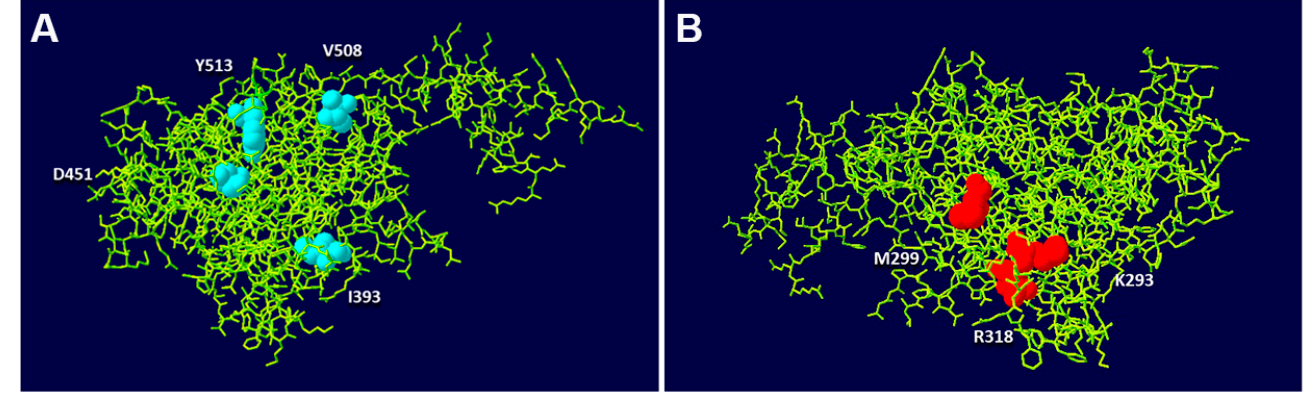
Figure 6. Residues affected by missense mutation spatially segregate according to biochemical impairment and phenotype severity. Residues affected by mutations from group 2 ( A ) and some of those in group 1 ( B ) (see text for details), were mapped on the 3D structure of the phosphatase domain of OCRL1 (PDB file 4CMN). Panels A and B correspond to two views of the OCRL1 phosphatase domain crystal structure after a rotation of ≈ 180 degrees.